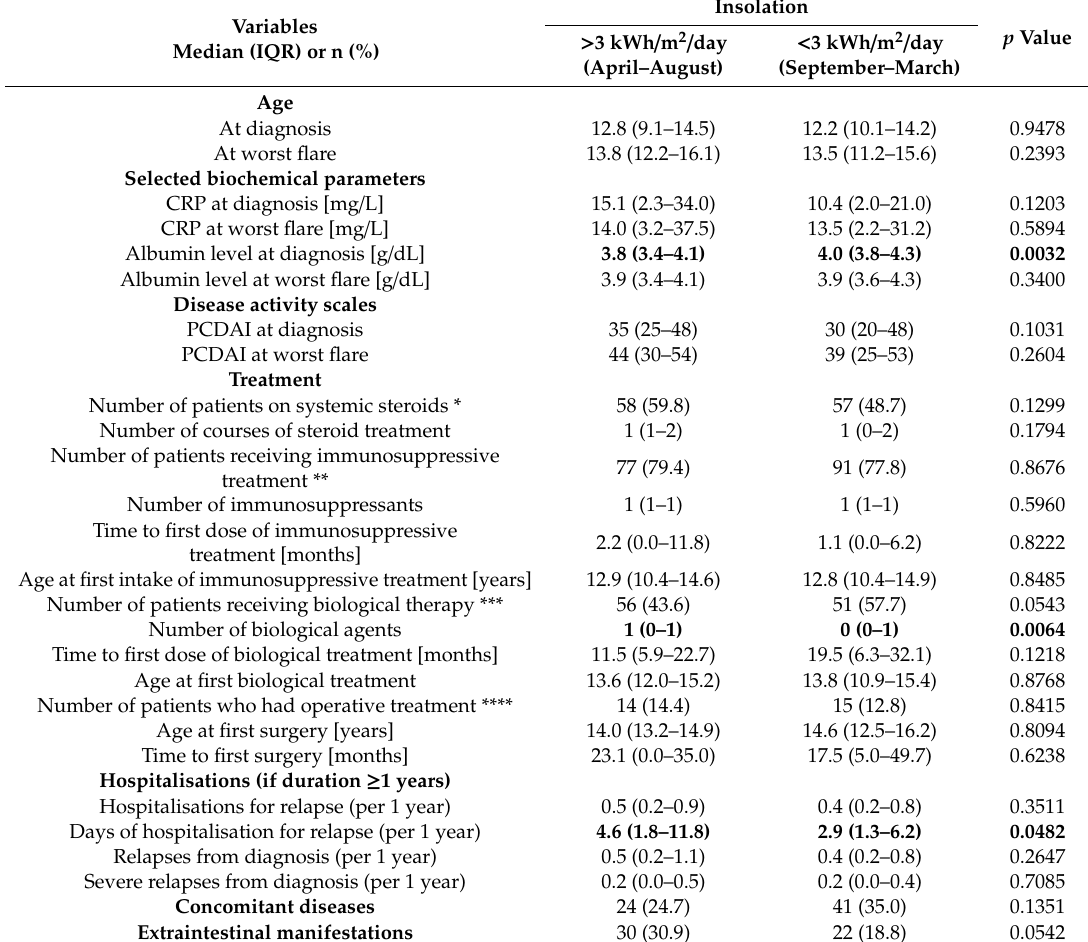
Table 1. Clinical characteristics of patients with Crohn’s disease depending on